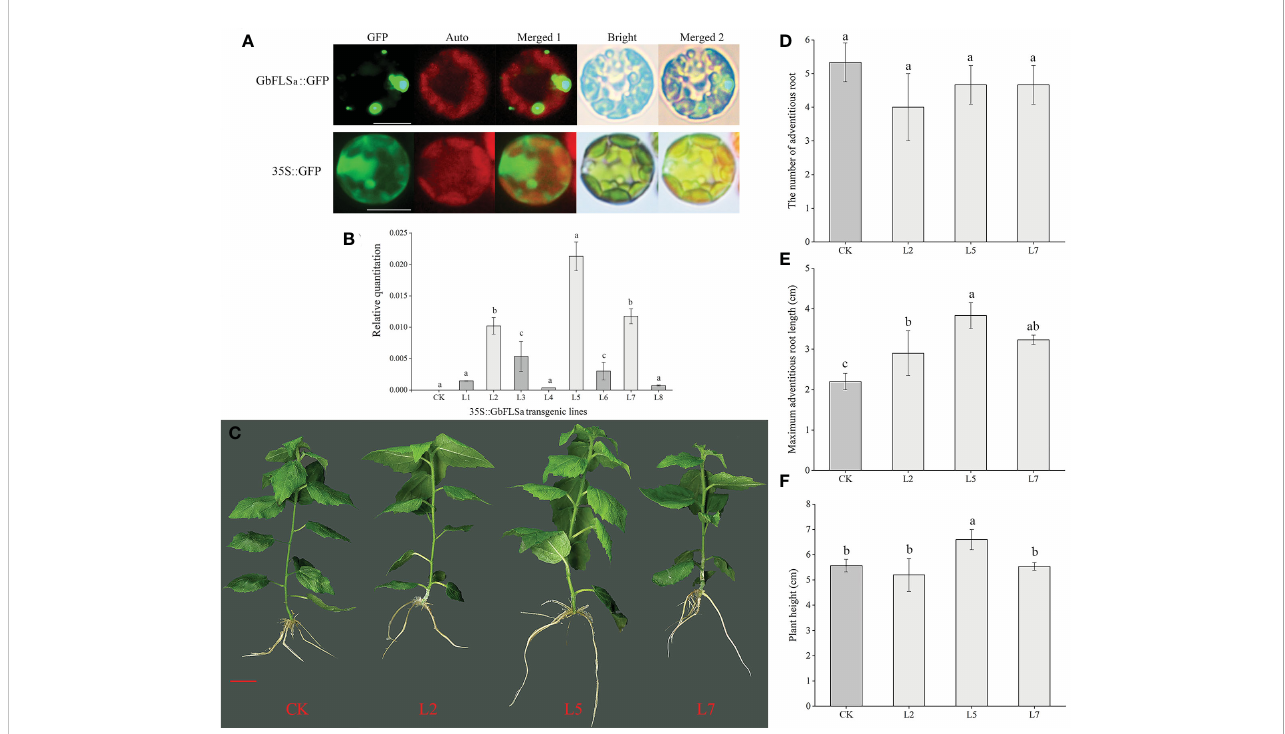
FIGURE 4 Subcellular localization of the GbFLSa protein and its expression and phenotype comparison analysis of CK Populus with transgenic Populus lines. (A) . Transient expression of the GbFLSa::GFP fusion protein and the 35S::GFP control in Populus mesophyll protoplasts. Scale bar, 10 m m. GFP: GFP fl uorescence; Auto: chlorophyll auto fl uorescence; Merged 1: GFP+ Auto; Merged 2: Merged 1+Bright. (B) . Relative quantitation analysis of GbFLSa transcript levels in CK Populus and eight independent transgenic Populus lines. (C) . Comparison of CK and transgenic Populus phenotypes in 30-day-old plants. The number of adventitious roots (D) , maximum adventitious root length (E) and plant height (F) of CK Populus and three independent transgenic Populus lines. Scale bar = 1 cm. Columns with different lowercase letters signi fi cantly (p<0.05) differed based on Duncan ’ s multiple range